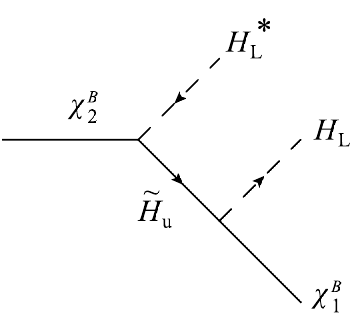
Figure 16. Example of diagram contributing to the baryon conserving decays of (cid:31) B